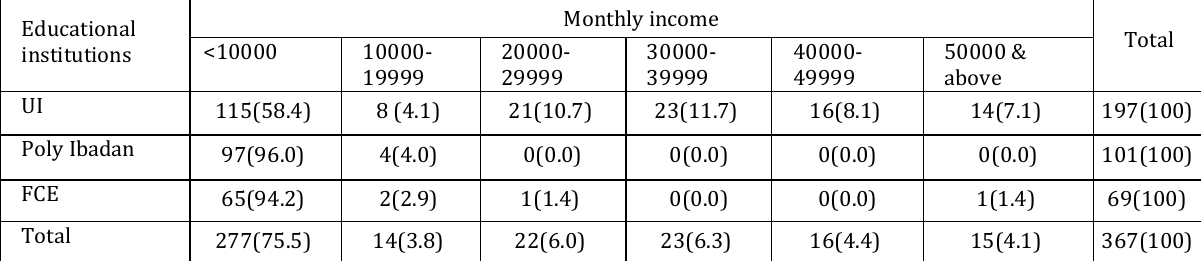
Table 5. Monthly income of students (source: Authors’ fieldwork data analysis,